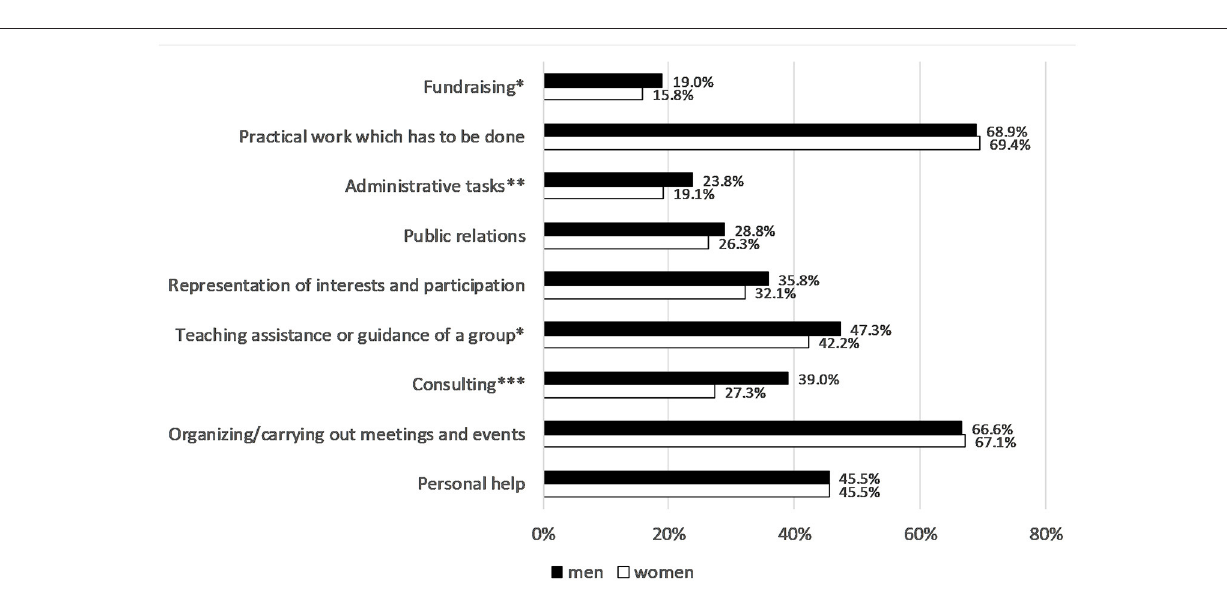
Frontiers in Sports and Active Living |